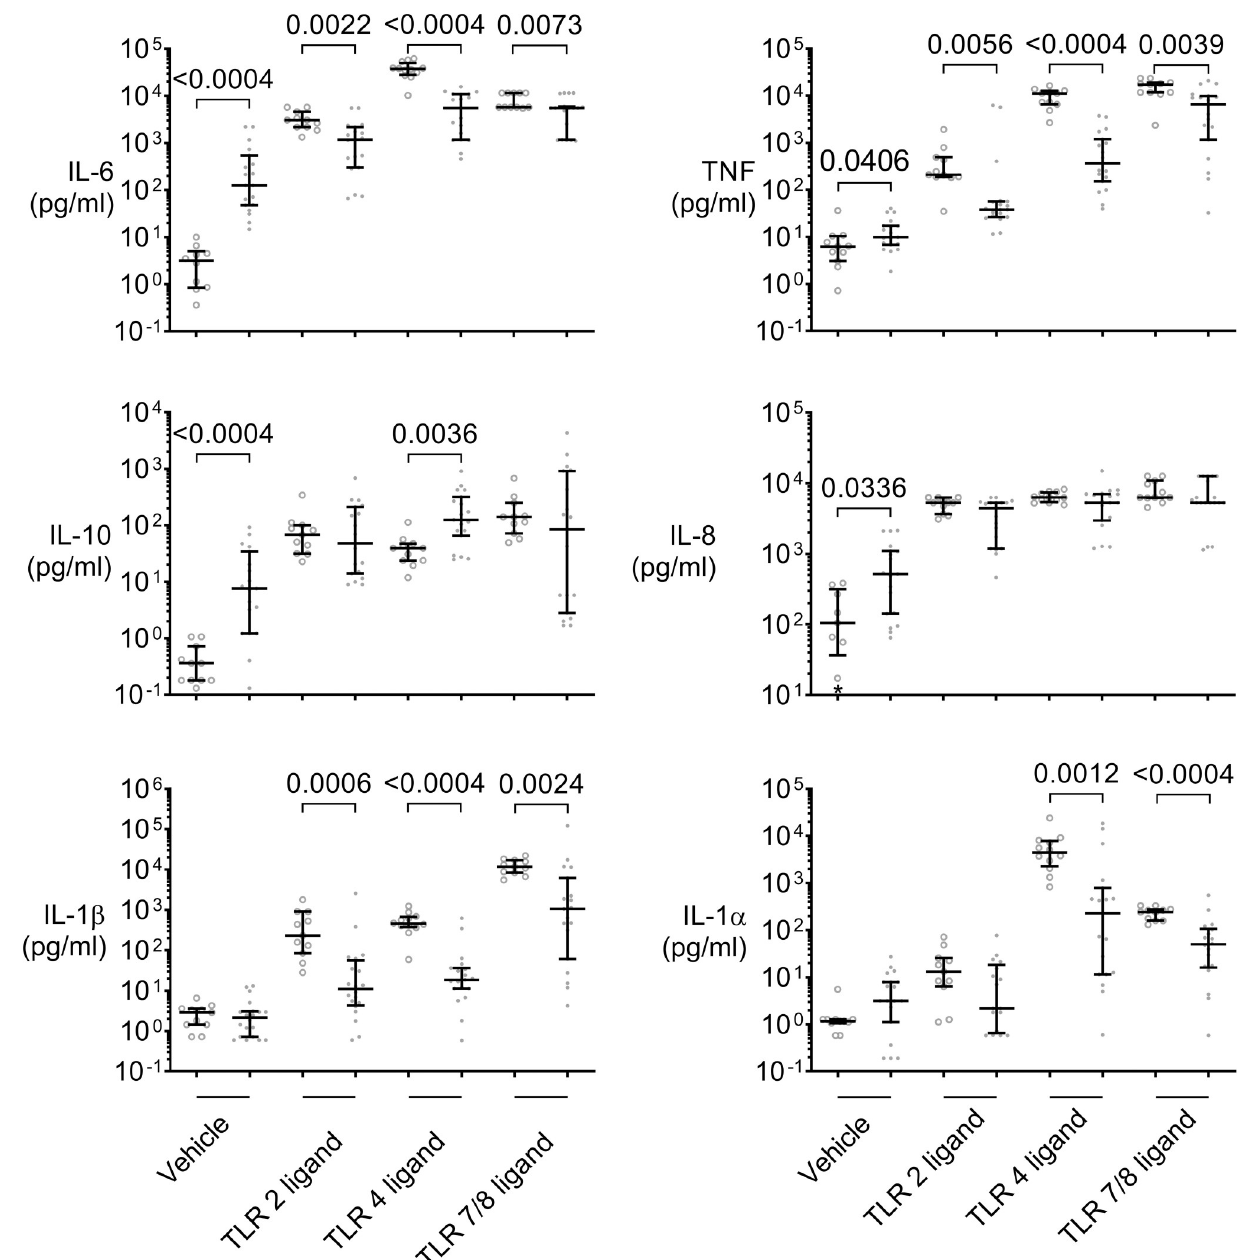
Fig 1. Diminished inflammatory cytokine responses to specific TLR2, 4, and 7/8 ligands in early sepsis patients’ whole blood. Supernatant cytokine concentrations in whole blood assays of 19 sepsis patients (dots) sampled within 24 h of meeting Sepsis-3 criteria and 11 healthy volunteer controls (open circles) incubated for 6 h with either vehicle, TLR2 ligand P 3 C, TLR4-specific ligand LPS Re595, or TLR7/8 agonist R848. Dot plots with median and quartiles. Mann-Whitney tests with Holm-Bonferroni correction for multiple testing. Sepsis patients’ samples show markedly decreased proinflammatory cytokine concentrations (IL-6, TNF, IL-1 α and IL-1 β ) in response to multiple TLR-ligands. In contrast, anti-inflammatory IL-10 is increased with TLR4 stimulation.